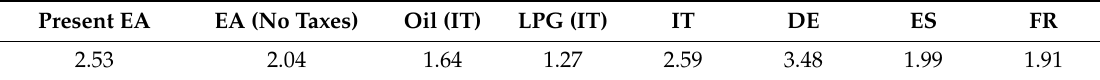
Table 8. Electricity/fuel price ratio for different fuels and countries. (EA, Euro Area electricity/gas price ratio; Oil, heating oil as fuel; LPG, heating LPG as fuel).